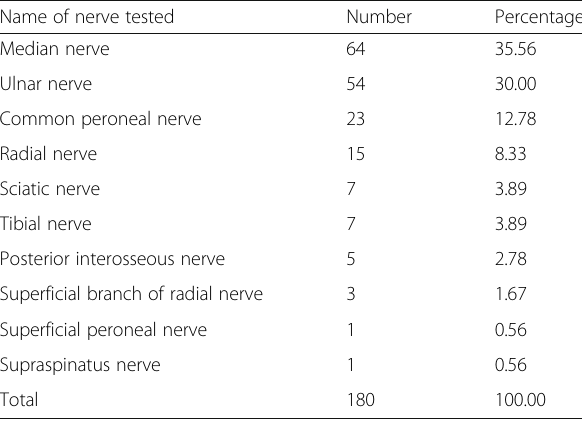
Table 4 Distribution of the peripheral nerves examined in the study